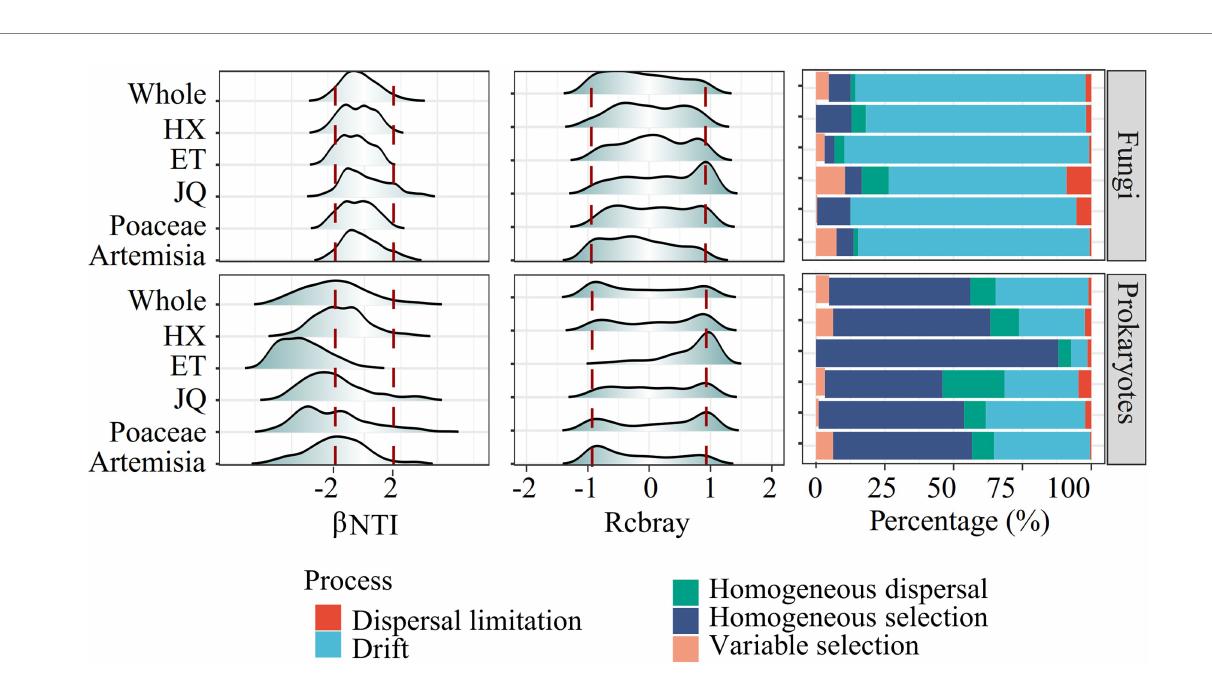
FIGURE 3 The β NTI, rcbray and the fraction of turnover in the assembly of soil microorganism